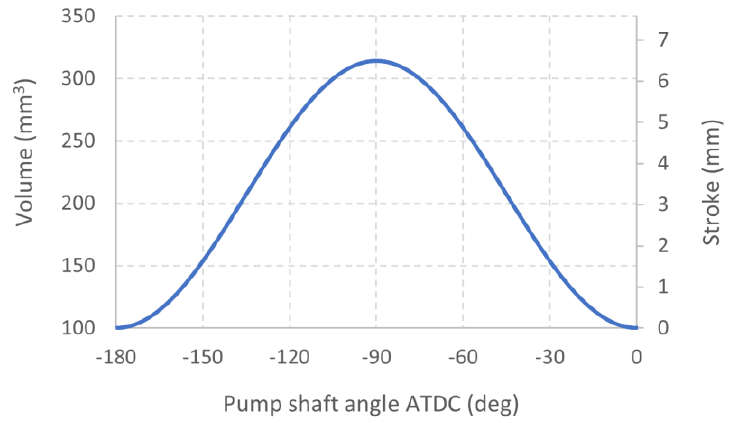
Figure 5. Piston stroke and volume of PWC vs. pump shaft angle.